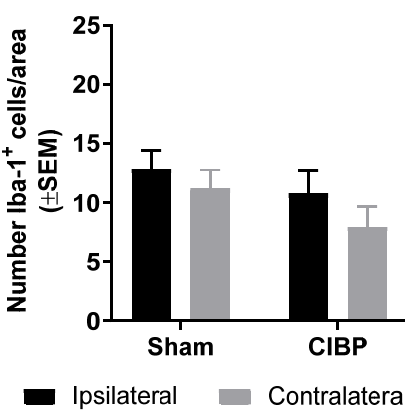
Figure 3 . Advanced CIBP in females did not induce spinal microglial reaction. The number of Iba-1 + cells was not significantly higher in the ipsilateral dorsal horn of the spinal cord of female cancer-bearing rats, compared with sham, at the humane endpoint (limb-use score of 0). The number of Iba-1 + cells was not significantly different between the ipsilateral and contralateral dorsal horns of cancer-bearing or sham rats. Sham n = 5, CIBP n = 5. Data are presented as mean ± SEM.